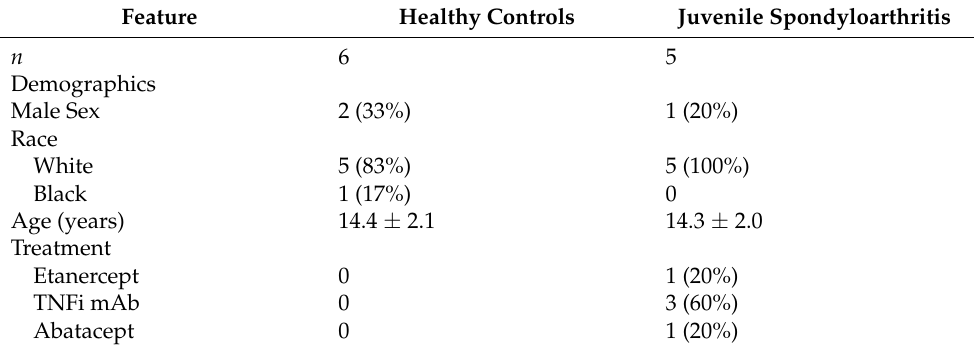
Table 1. Demographic and clinical variables of the study population. Abbreviations: TNFi mAb, tumor necrosis factor inhibitor (monoclonal